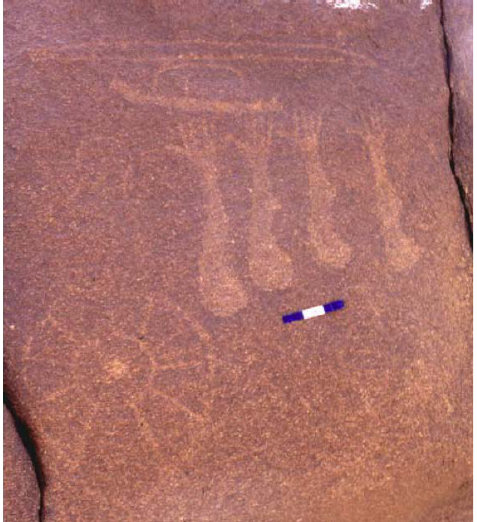
Figure 28. A series of human arms with hands and several other elements presenting an enigmatic